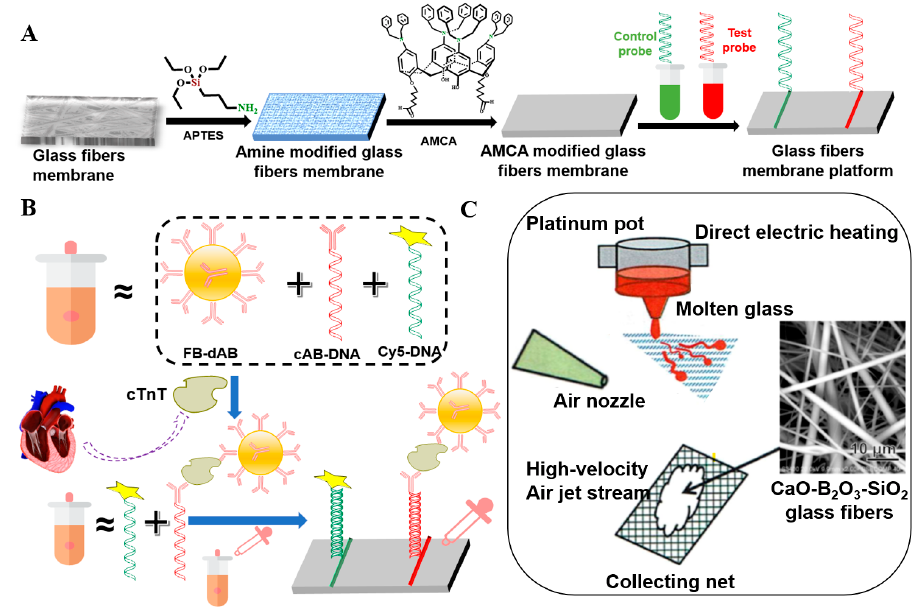
Figure 13. ( A ) DNA − modified glass fiber membranes by using the DAGON method. ( B ) cTnT was detected by antibody coupling with fluorescent beads. Reproduced with permission from reference [69]. Copyright © 2012 The Analyst . ( C ) Schematic representation of the preparation of glass fibers. Reproduced with permission from reference [113]. Copyright 2022 Materials In Medicine .